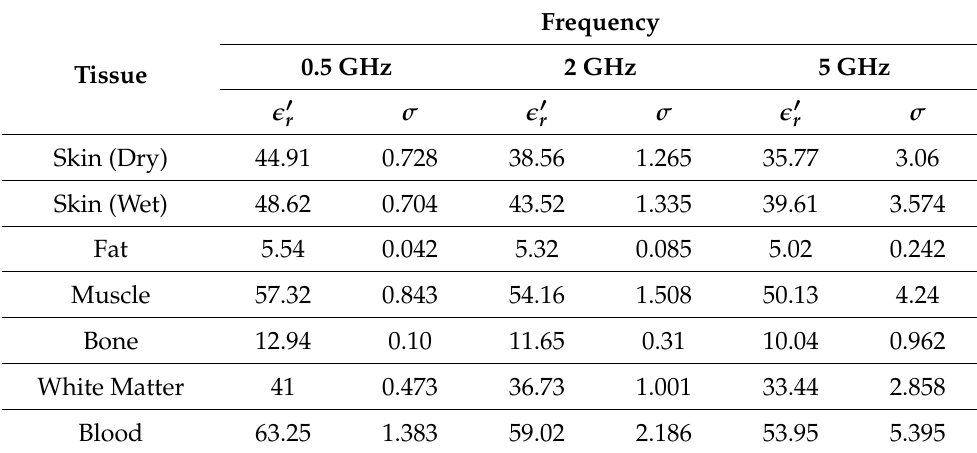
Table 1. Dielectric properties of human body biological tissues at different frequencies